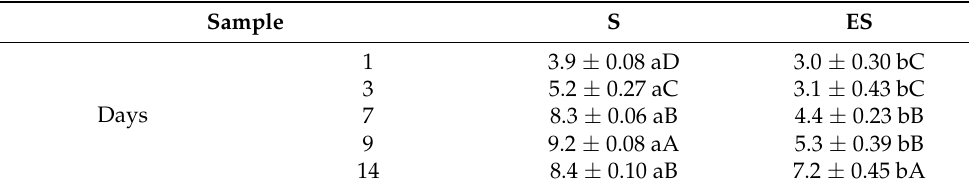
Table 10. Growth of Shew. putrefaciens (log cfu/g) in fish burgers for 14 days of storage: with inoculum (S); with 8% of ethanol-water extract and inoculum